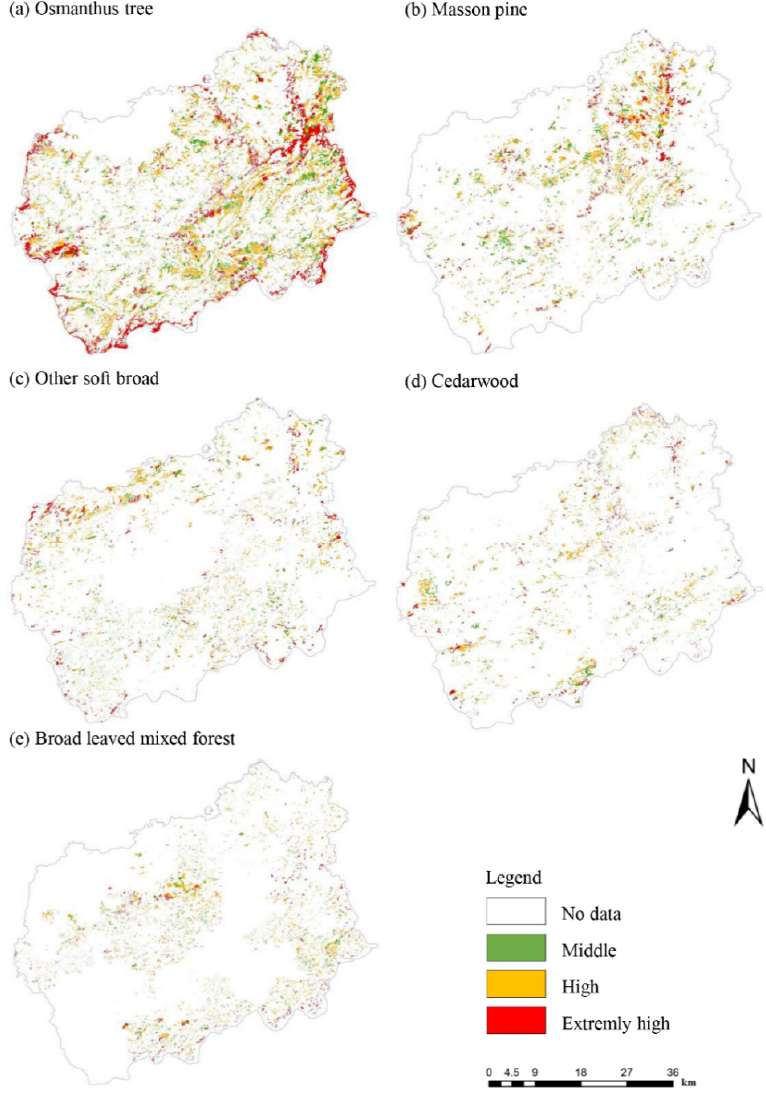
Figure 9. Spatial distribution map of landslide susceptibility of dominant tree species in Qianxi County.